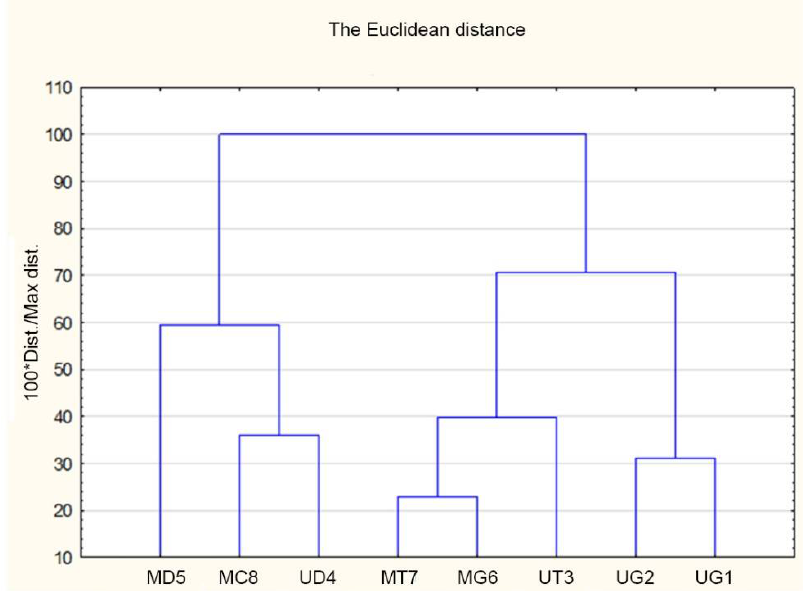
Figure 2. Dendrogram of similarity of species dominance in Coleoptera assemblages in managed (MD5, MG6, MT7, MC8) and unmanaged (UG1, UG2, UT3, UD4) pine stands in western Poland. The percentage shares of individual trophic groups in the beetle assemblages differ in the analysed stands (Table 4). Table 4. Mean percentage shares of beetle species and individuals captured in managed and unmanaged pine stands in western Poland in terms of trophic groups. Unmanaged Stands Managed Stands Mean Share of Species Mean Frequency of Mean Share of Species Mean Frequency of Trophic Group in the Trophic Group Individuals in the in the Trophic Group Individuals in the (%) Trophic Group (%) (%) Trophic Group (%)